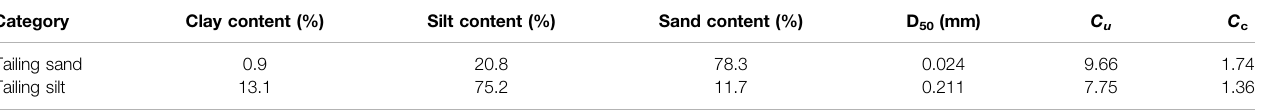
TABLE 1 | Particle size distribution parameters of the tailings.